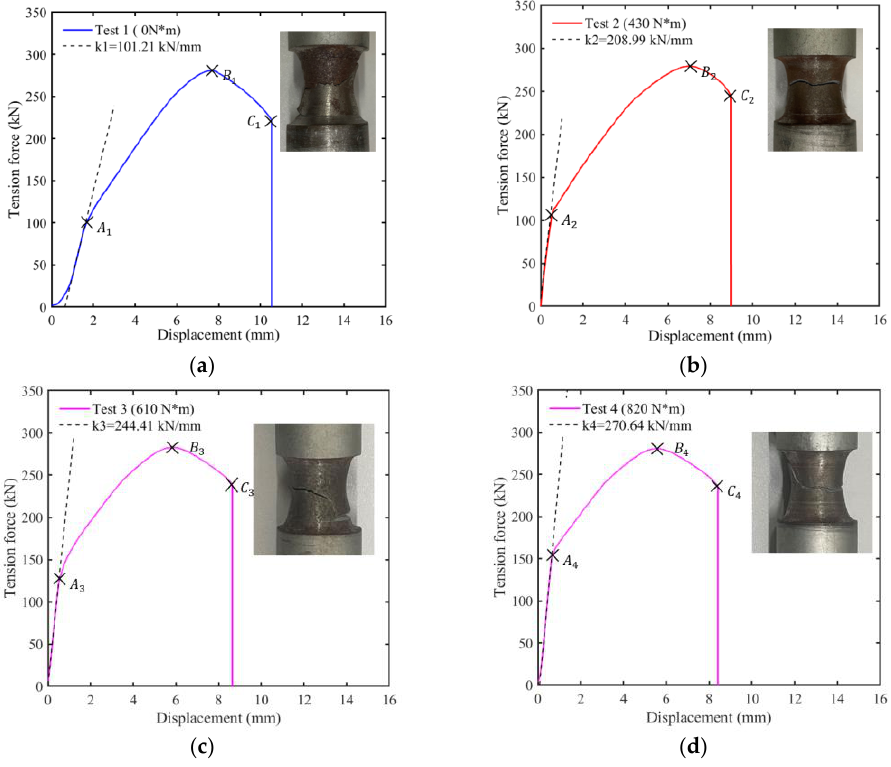
Figure 14. The tensile force and the tensile displacement response curve: ( a ) Test 1 (T P = 0 N ∙ m), ( b )